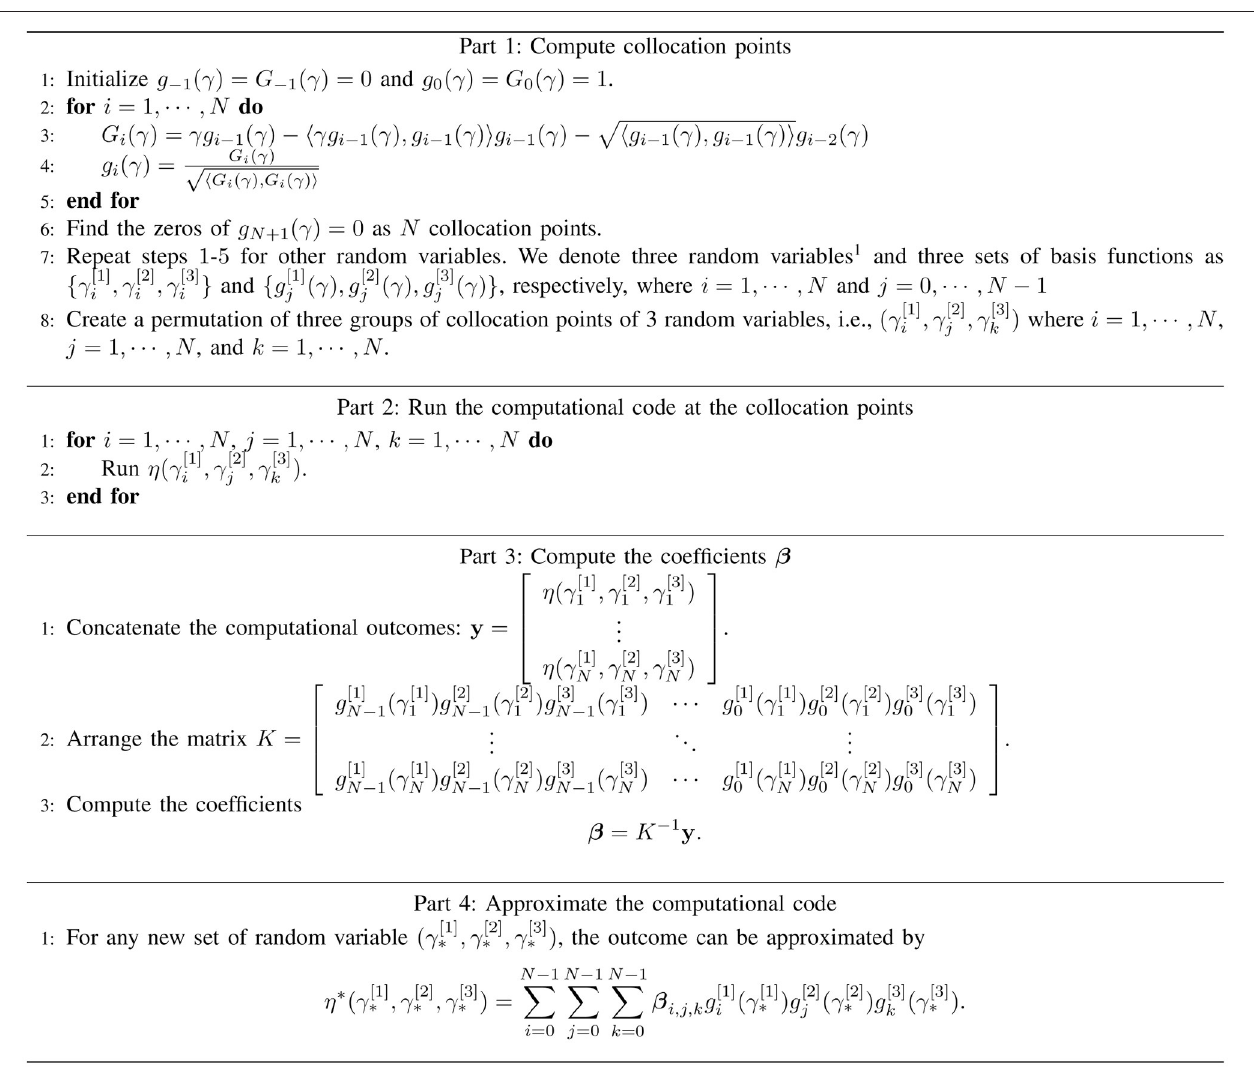
FIGURE 3 | The algorithm of the PCM, which consisting of the computation of collation points (part 1), the realizations of physical-based model at collocation points (part 2), the computation of coefficients (part 3), and the generalization of approximated outputs (part